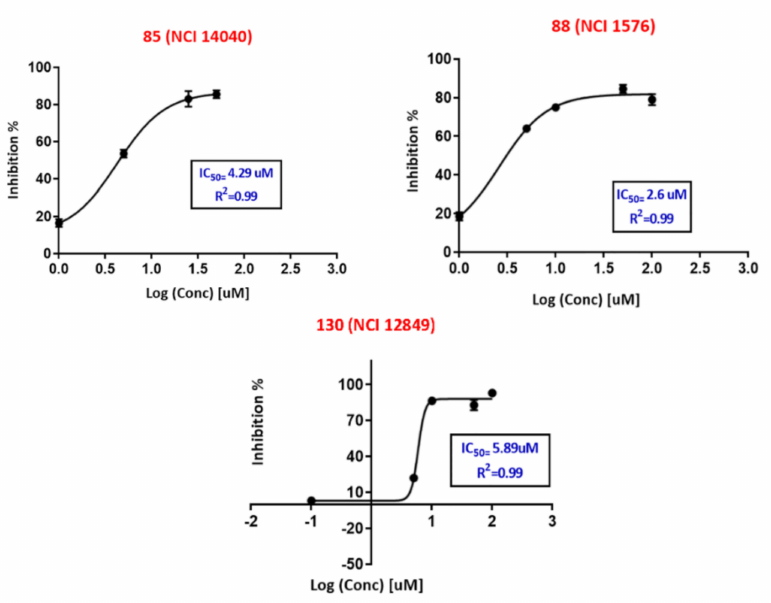
Figure 5. Chemical structures of the five hits that demonstrated inhibitory activity against Aurora-A kinase using Z (cid:48) -LYTE ® assay (Invitrogen, Carlsbad, CA, USA) kinase inhibition assay with IC 50 values summarized in Table 5. The identities and purities were validated by NMR and mass spectroscopy in (Figures S3–S38 in Supplementary Data). Table 5. The IC 50 values of the five active hits that produced anti-Aurora-A kinase inhibition above 50% at 10 µ M using Z (cid:48) -LYTE ® kinase assay (Invitrogen, Carlsbad, CA, USA), sum of their critical contacts, and their predicted activity. These high-ranking hits captured by Refined-Hypo(SB-1) derived from Hypo(SB-1) pharmacophore were docked into Aurora-A Kinase binding pocket (3w2c) using the docking-scoring settings of (SB-1). Their docked poses were analyzed to identify their critical binding contacts (marked by dbCICA model Table 2) and were used to predict their Ki values or activities by substituting the sum of binding contacts in the respective dbCICA regression equations (Table 1). Steps of activity prediction were also employed using docking / scoring settings of (SB-2) dbCICA model to assess the similarity extent in “predicted activity” of both (SB-2) model and the better performing (SB-1) model. SB-1 Hit (NCI Code Number) a